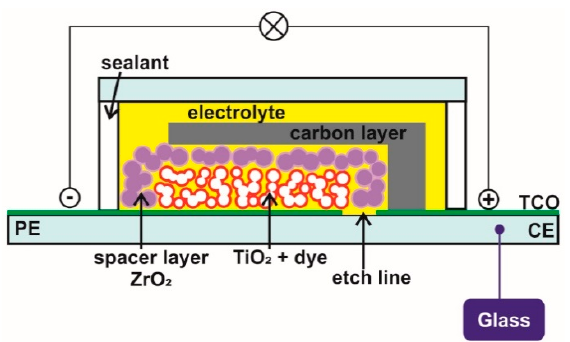
Figure 4. Illustration of a typical assembly of a monolithic DSSC with all the key components [25,92– 95]